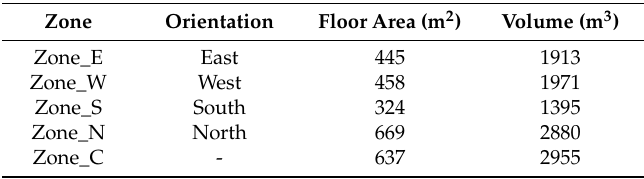
Figure 5. Google SketchUp modeling. Table 2. Scale of the space.